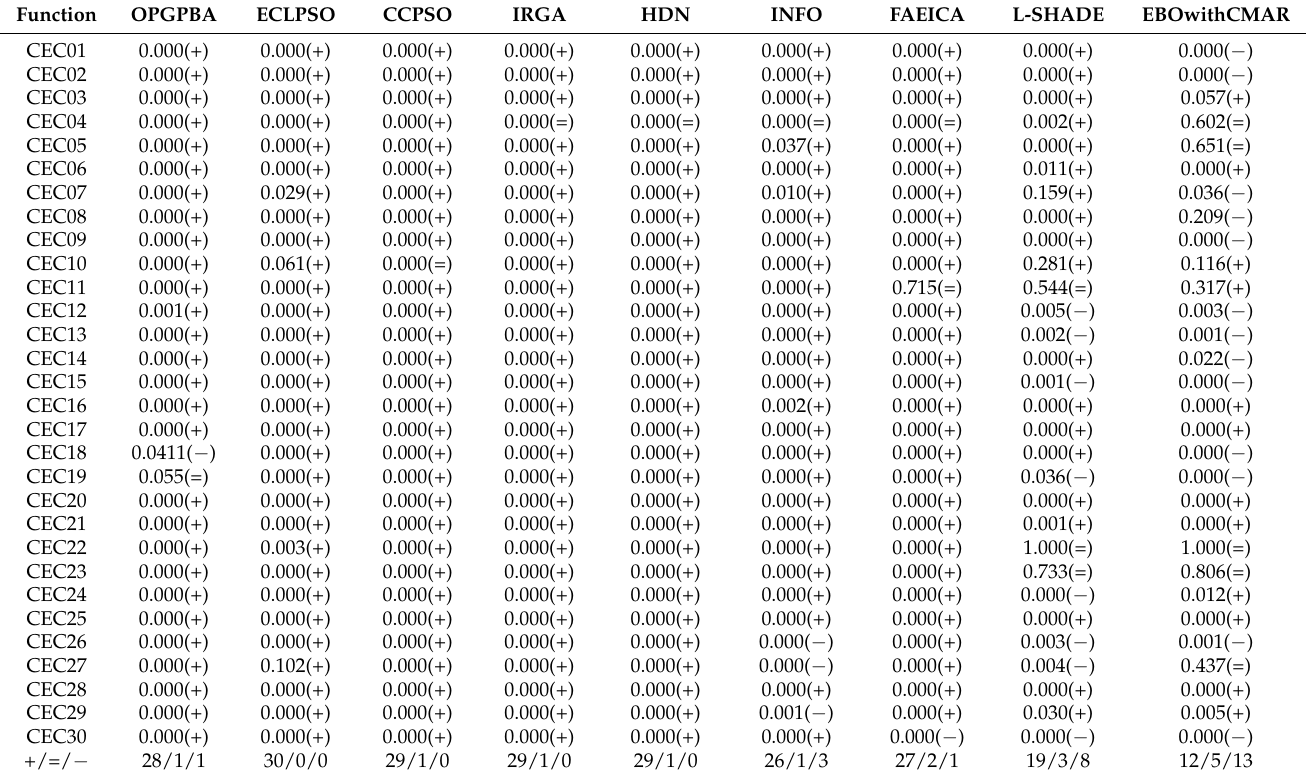
Table 11. Wilcoxon signed rank test results ( p -values) of 10-D CEC2017 problem